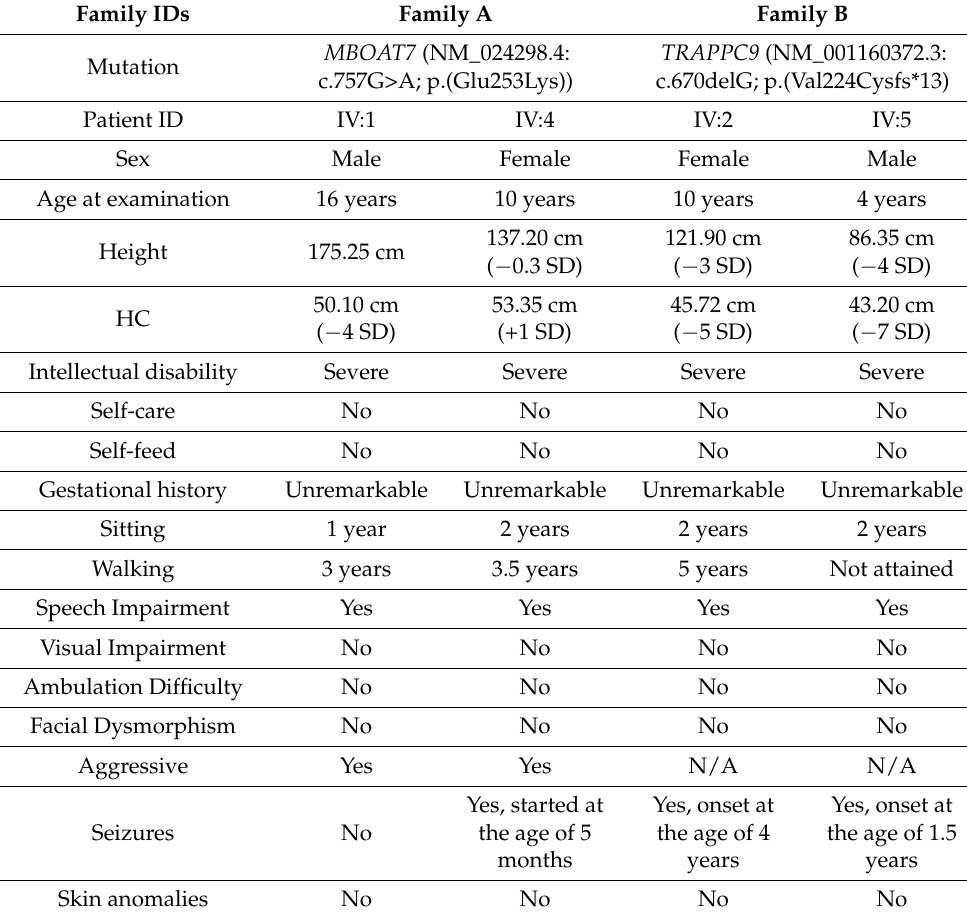
Table 1. Clinical information of the families A and